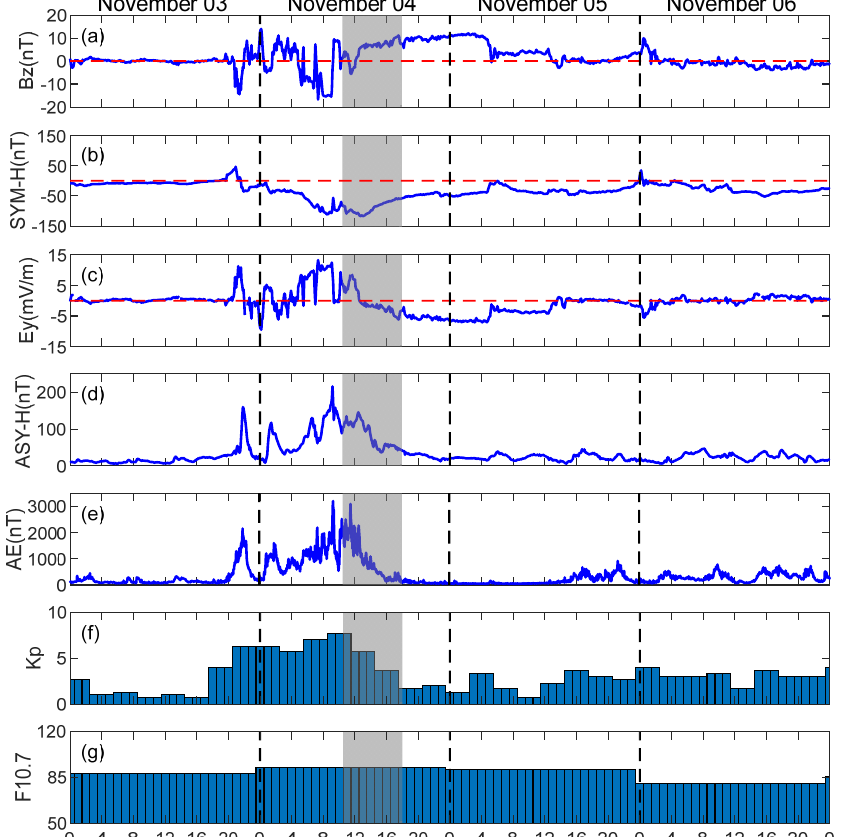
Figure 2. Geomagnetic conditions from 03 to 06 November 2021: ( a ) IMF Bz component in Geocentric Solar Magnetospheric (GSM) coordinates; ( b ) symmetric ring current index (SYM-H); ( c ) east–west component of the interplanetary electric field (Ey) index; ( d ) asymmetric ring current (ASY-H) index; ( e ) Auroral electrojet (AE) index; ( f ) Kp index; ( g ) F10.7 index. The shaded area indicates the time period of the positive ionospheric storm.